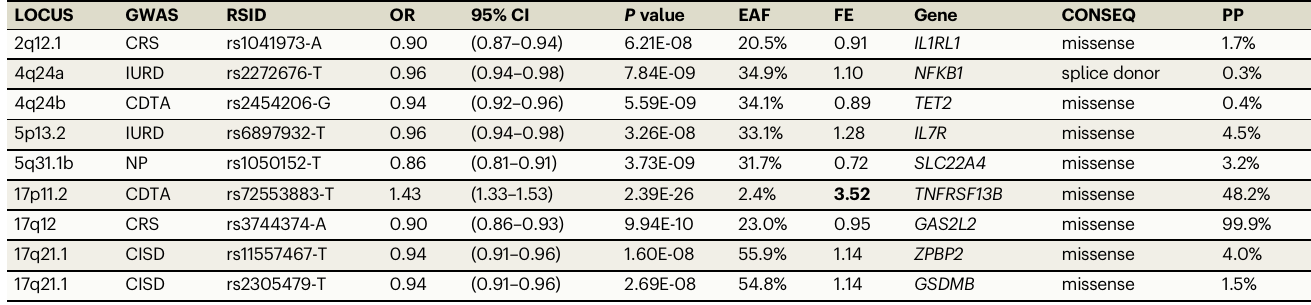
GWAScolumndenotesthegenome-wideassociationstudywherethevariantisidenti fi ed.Oddsratiosand p -valuesarewithregardtothephenotypeinGWAScolumn;themostspeci fi cphenotypeis representedifthevariantappearsinseveralGWAS.Oddsratios(OR)wereestimatedusinglogisticregression(Methods). P